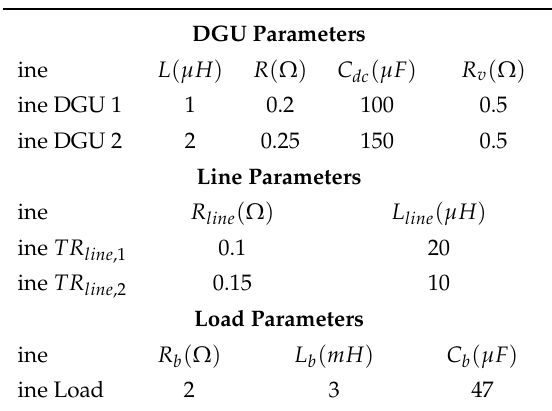
Table 1. Microgrid